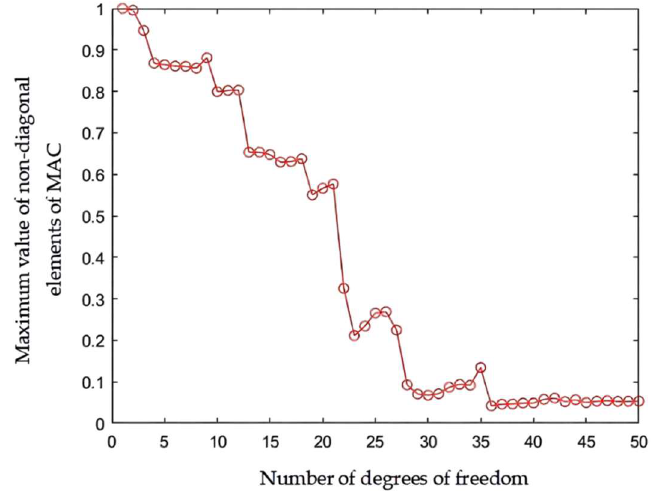
Figure 6. Variation curve of the maximum non-diagonal elements of the MAC matrix versus the number of measurement points.